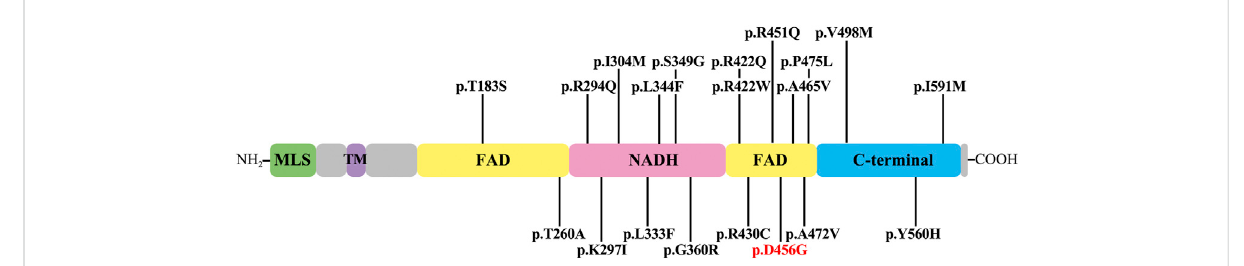
FIGURE 6 AIFM1 mutations associated with auditory neuropathy. The novel variant identi fi ed in this study is highlighted in red. The structural domains in AIFM1 shown include mitochondrial localization signal (MLS), transmembrane domain (TM), fl avinadenine dinucleotide (FAD), nicotinamide adenine dinucleotide (NADH), and C-terminal domain